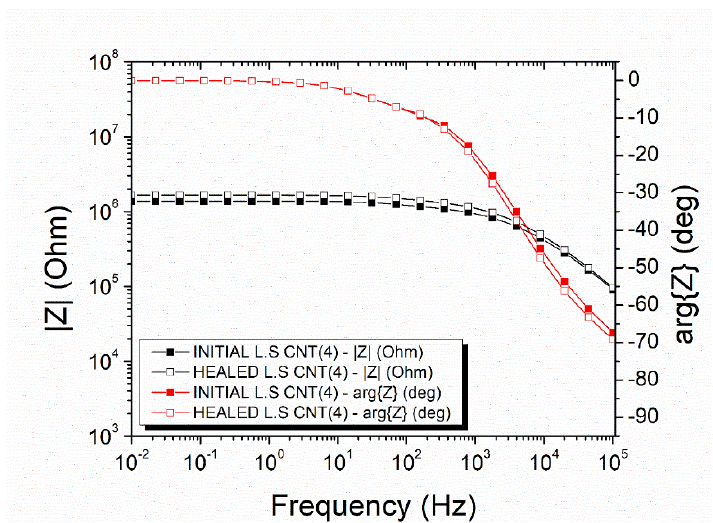
Figure 13. Impedance plots of lap strap specimens with nano-enhanced micro-capsules.